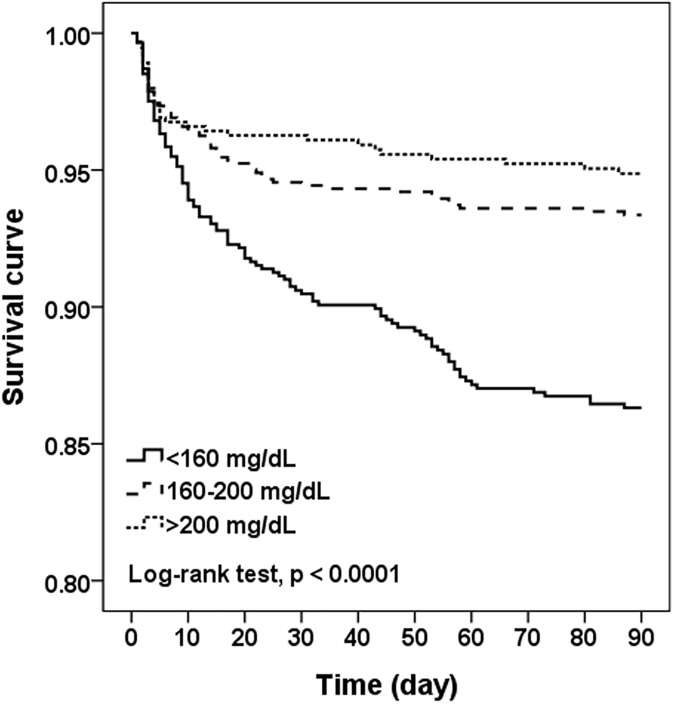
Three-month survival in different cholesterol groups in 2444 ICH patients.